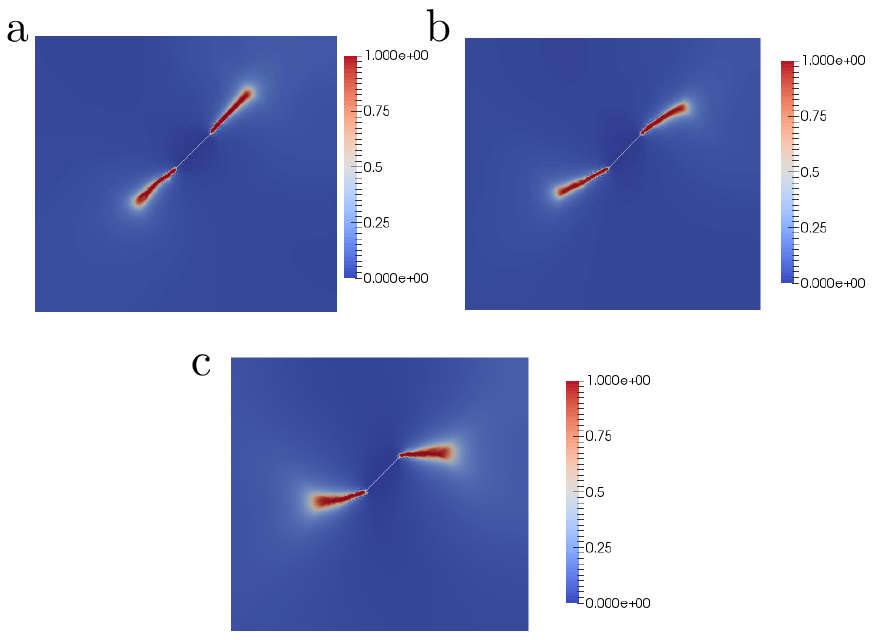
Figure 7. Different tensile-tensile loading scenarios for a specimen with a single flaw: predicted damage patterns. ( a ) Vertical traction and horizontal traction with ¯ u y / ¯ u x = 1. ( b ) Vertical traction and horizontal traction with ¯ u y / ¯ u x = 2. ( c ) Vertical traction and horizontal traction with ¯ u y / ¯ u x =